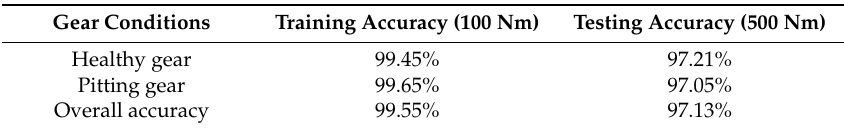
Table 6. Detection results at mixed rotating speeds (trained with light loading samples and tested with heavy loading samples).